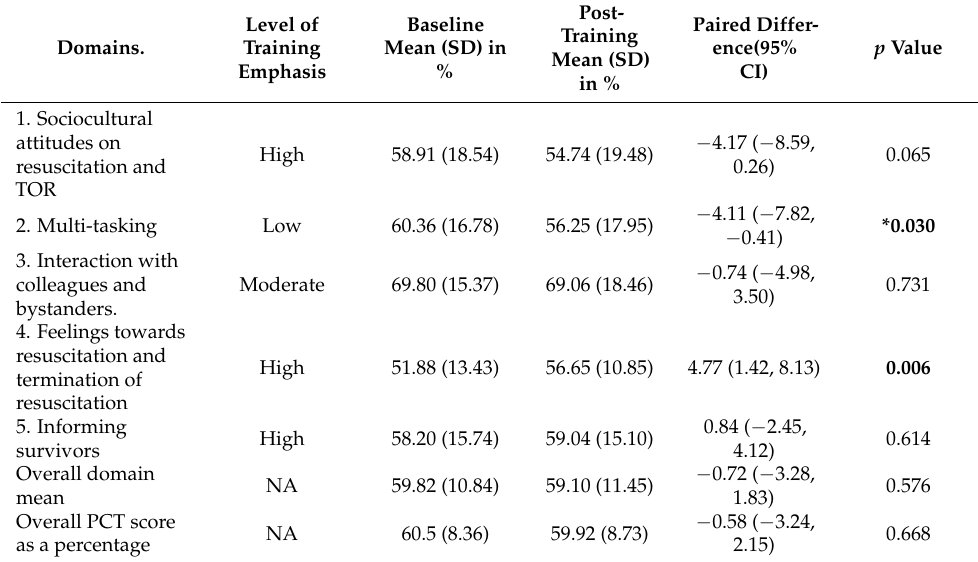
Table 3. Baseline and post-training psychological comfort total percentage in the various domains and the paired difference ( n =